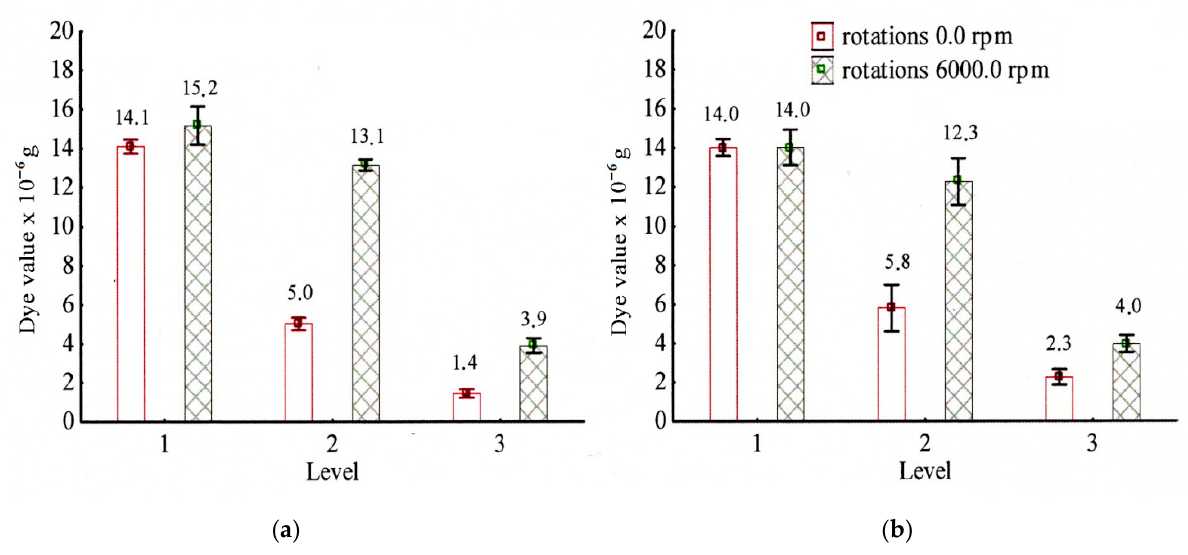
Figure 4. Distribution of the dye at individual levels of the tree crown depending on the distance between the trees and the rotational speed of the drone rotors at air-injector twin flat spray nozzle: ( a ) tree distance 0.5 m; ( b ) tree distance 1.0 m.